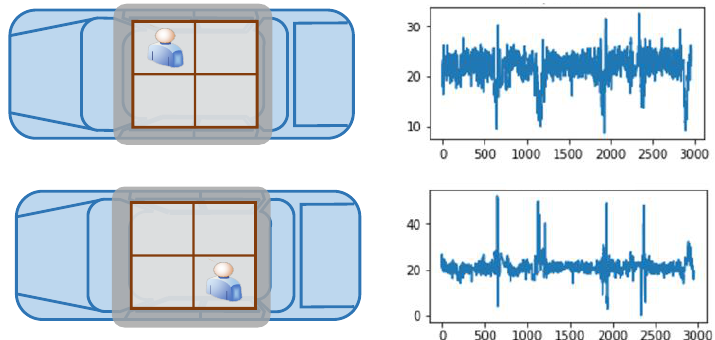
Figure 8. RSSI waveforms for different personnel positions in the vehicle.